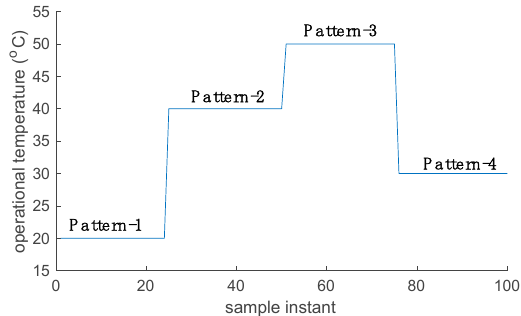
Figure 3. Temperature profile in the PRO system in scenario 1.